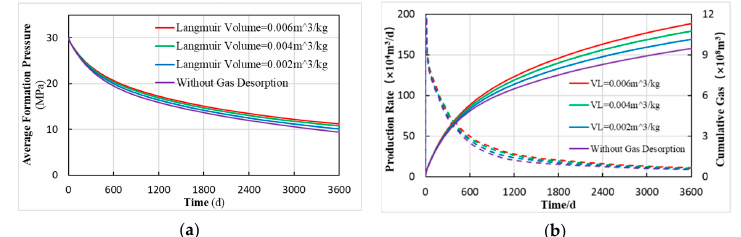
Figure 8. Reservoir pressure distribution at different production times. ( a ) T = 1a; ( b ) T = 3a; ( c ) T = 5a; ( d ) T = 10a.